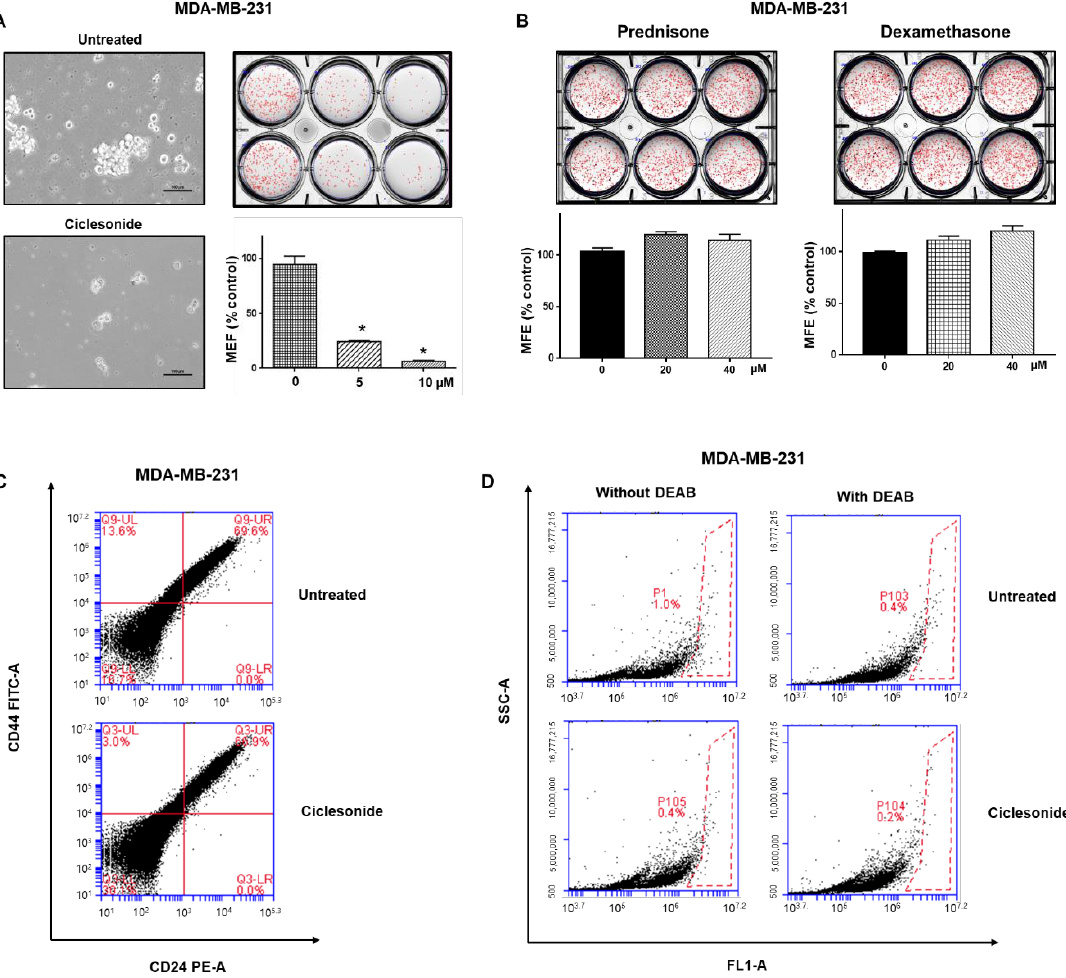
Figure 3. Ciclesonide reduces the formation of mammospheres from breast cancer cells. ( A ) Mammospheres were cultured for seven days in MammoCult medium. Treatment with ciclesonide (5 and 10 µ M) reduced mammosphere formation to 5% that under control conditions. The experiment was conducted with cancer cells treated with ciclesonide in a single passage of spheres formation assay. * p < 0.05 vs. the control. Experiments were repeated three times. ( B ) Treatment with prednisone or dexamethasone (20 and 40 µ M) did not reduce the mammosphere formation efficiency (MFE). The experiment was conducted with cancer cells treated with ciclesonide in a single passage of spheres formation assay. Experiments were repeated three times. ( C ) The proportion of CD44high / CD24low cells was quantified with anti-CD44-FITC and anti-CD24 PE antibodies. The CD44high / CD24low cell proportion was significantly decreased after ciclesonide treatment. ( D ) The population of ALDH1-positive cells was quantified by an ALDEFLUOR kit. The proportion of ALDH-positive cells was reduced after ciclesonide treatment. The right panel shows red-dot plots of negative control cells treated with the aldehyde dehydrogenase (ALDH) inhibitor DEAB. The left panel shows ALDH-positive cells not treated with DEAB.